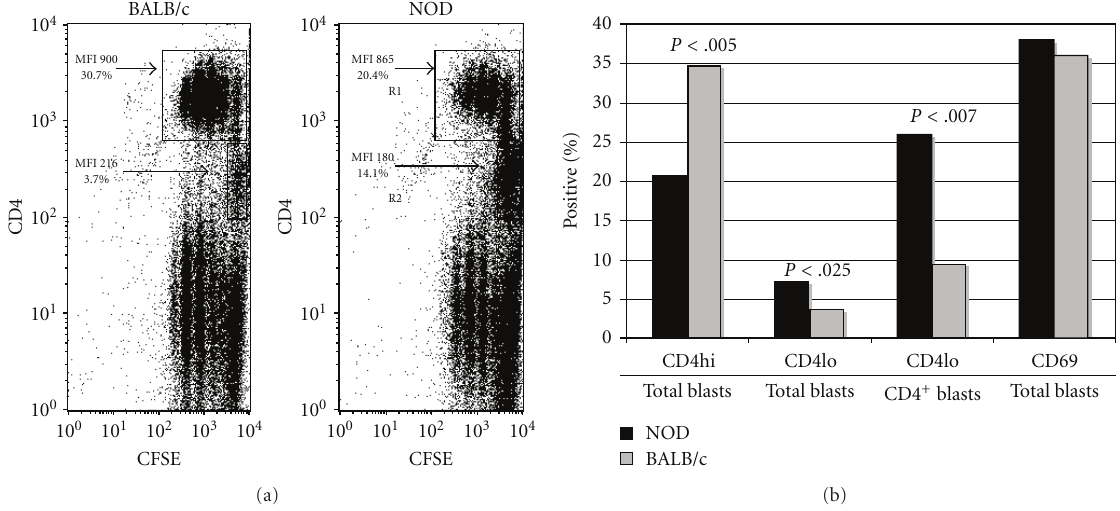
Figure 3: “CD4lo” T cells are increased among NOD Con A blasts. (a) Spleen cells from na¨ıve NOD or BALB/c mice were loaded with CFSE and stimulated for 72hrs with Con A. The resulting blasts were stained with anti-CD4-PE and analyzed by flow cytometry. The results are representative of four experiments. The data are expressed as dot plots of ungated cells (100,000 events). The numbers in the plots represent the percentage of total cells in regions R1 (CD4 MFI > 800) and R2 (CD4 MFI < 250). (b) The values in the bar graph reflect the mean percentage of cells in each category, from 3 separate experiments (100,000 events collected for each sample). Student’s t -test was used to compare responses between NOD and BALB/c blasts (only P -values reaching significance, < .05, are